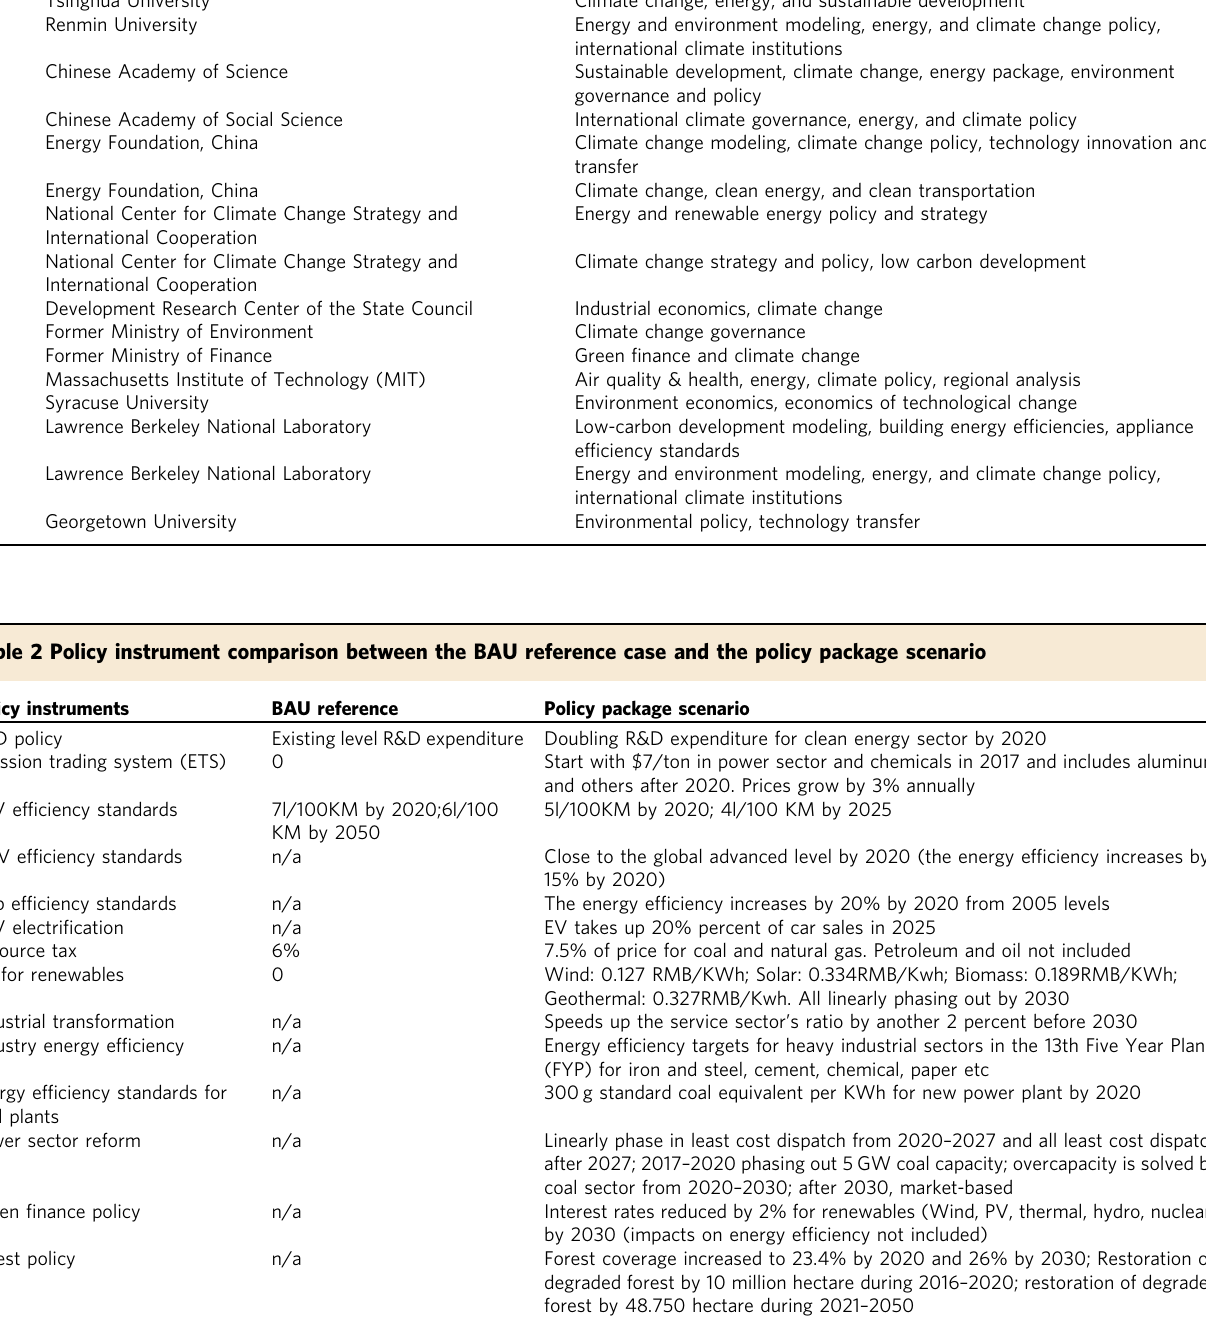
Energy ef fi ciency standards for coal